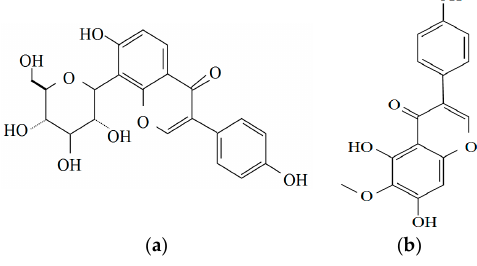
Figure 1. Structures of two bioactive components in Kudzu: ( a ) Puerarin; and ( b ) Tectoridin.